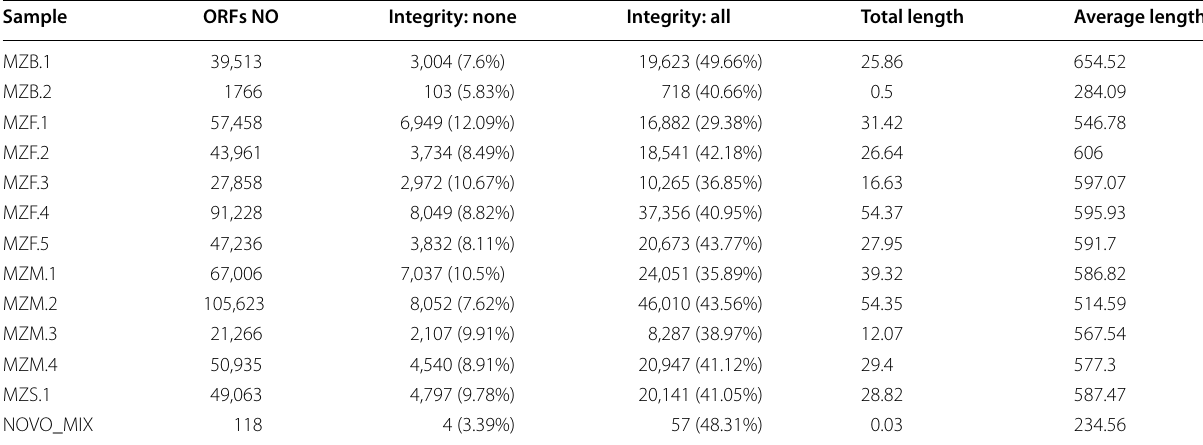
Table 5 The statistical information of predicted gene